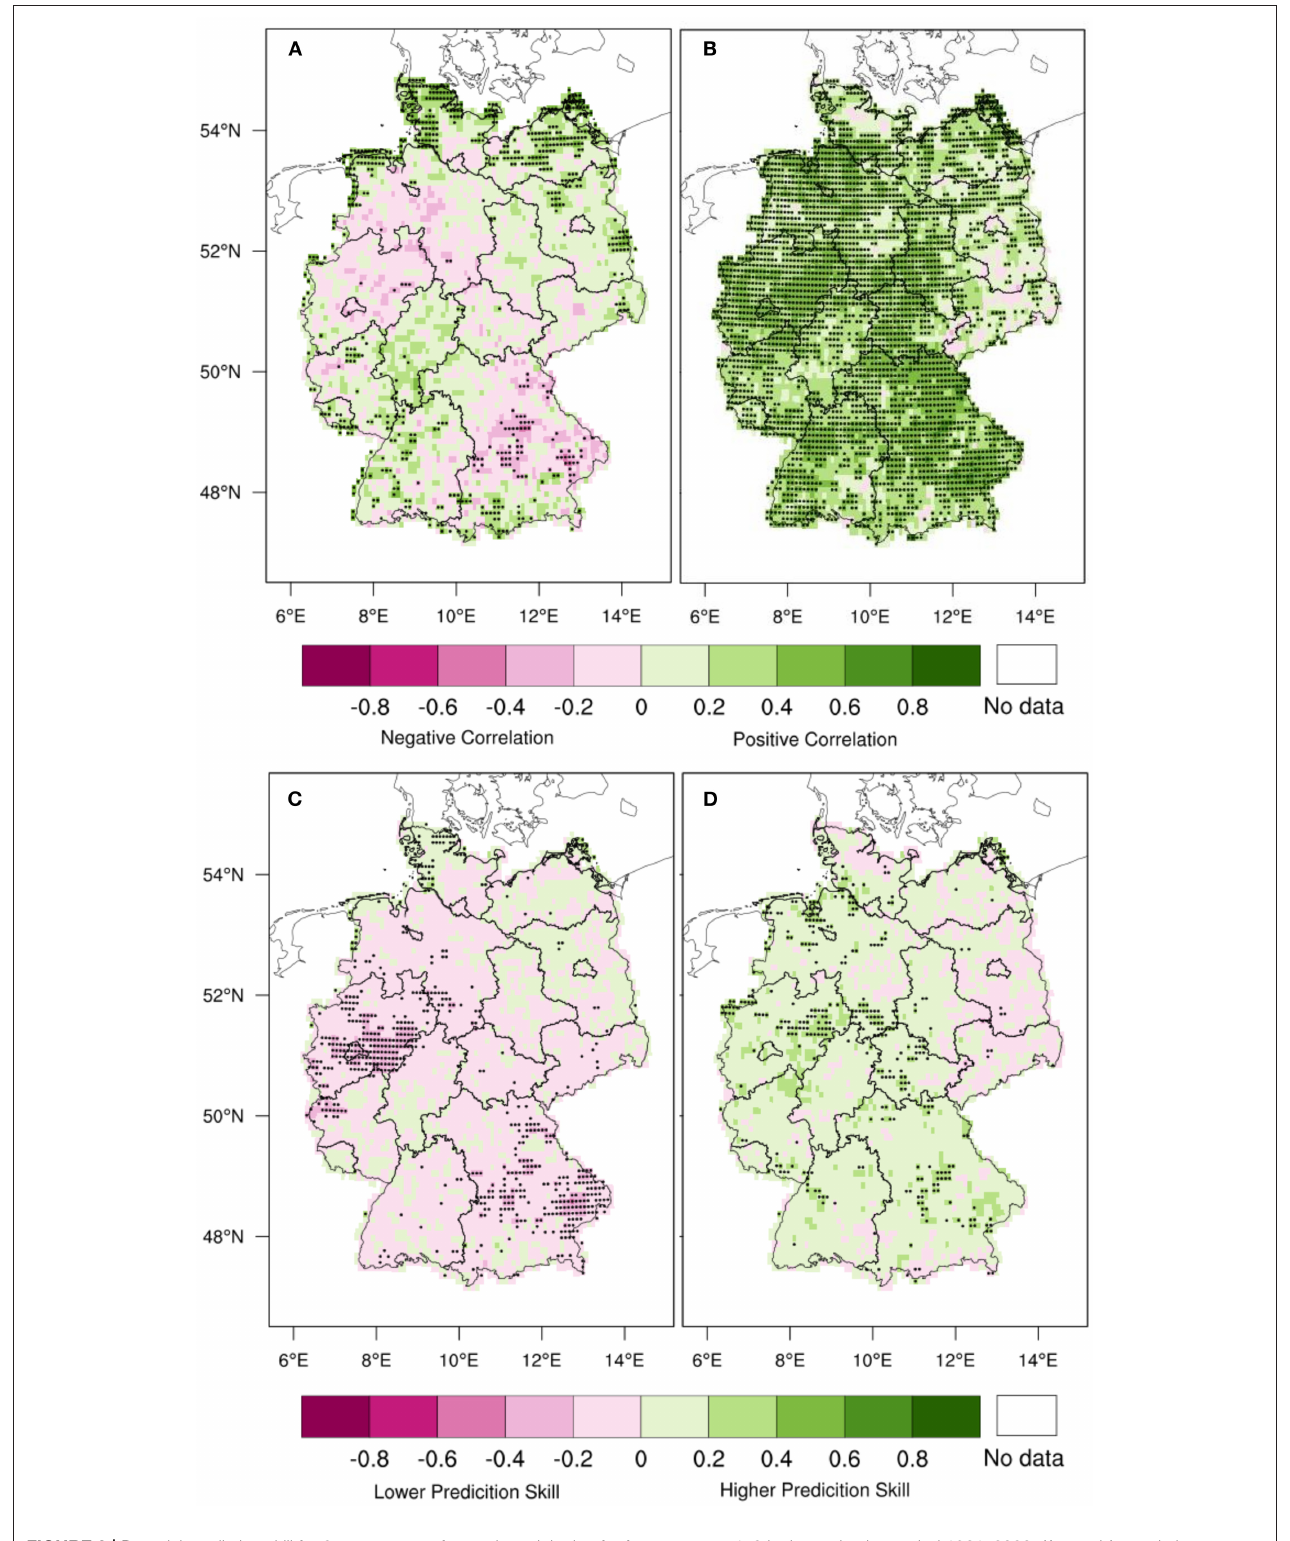
FIGURE 3 | Decadal prediction skill for 3-year means of annual precipitation for forecast years 1–3 in the evaluation period 1961–2020: (Anomaly) correlation coefficient between EPISODES at standard (A) or optimized recalibration (B) and HYRAS observations and RPSS of EPISODES at standard (C) or optimized recalibration (D) compared to the observed HYRAS climatology as reference prediction. Dots indicate significant skill (significance level of 95%).